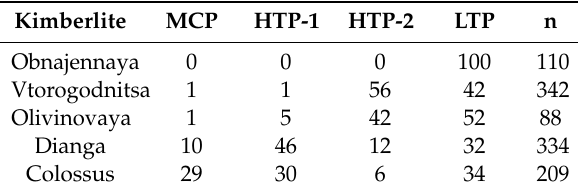
Table 1. Xenolithic olivines of di ff erent types: percentages in di ff erent kimberlites. Colossus kimberlites data from work in [29]. Symbols for kimberlite types are same as in Figure 5. n is number of analyzed grains.